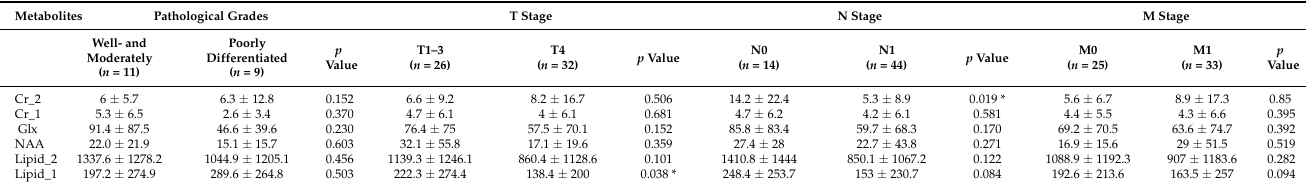
Table 3. Differences in MRS metabolites relative to pathological grades and TNM stage.